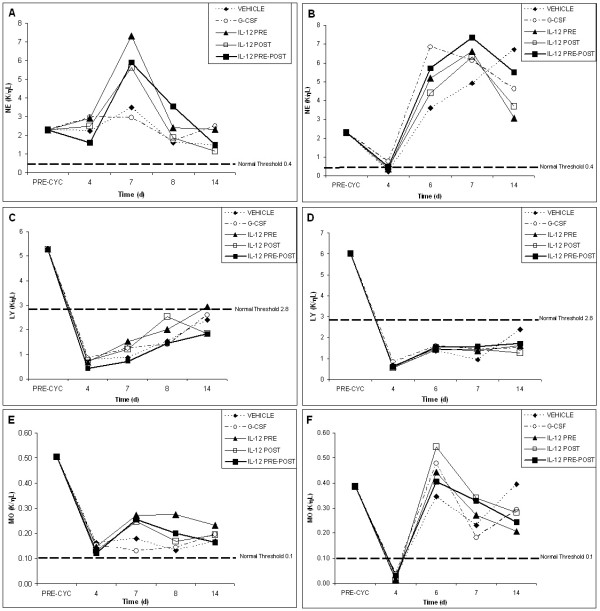
White blood cell recovery profiles for vehicle, G-CSF, IL-12 pre-only, IL-12 post-only and IL-12 pre-post treatment groups following chemotherapy. White blood cell recovery profiles are shown for the EL4 tumor model (left; A, C and E) and the Lewis lung cancer model (right; B, D, and F) for neutrophils (A and B), lymphocytes (C and D) and monocytes (E and F). Pre-chemotherapy blood values reflect an average of all animals in both groups (80 mice) before cyclophosphamide and tumor inoculation. The normal threshold values for neutrophil, lymphocyte and monocyte counts in C57BL/6 mice are indicated. EL4 mice received a cyclophosphamide dose of 250 mg/kg and the LL mice received a cyclophosphamide dose of 225 mg/kg. IL-12 treated mice received a total dose of 50 ng (pre-only) and 150 ng (post-only and pre-post (pre-post dose was split 50 ng before and 100 ng after cyclophosphamide)), whereas G-CSF treated mice received a total dose 1.5 μg.